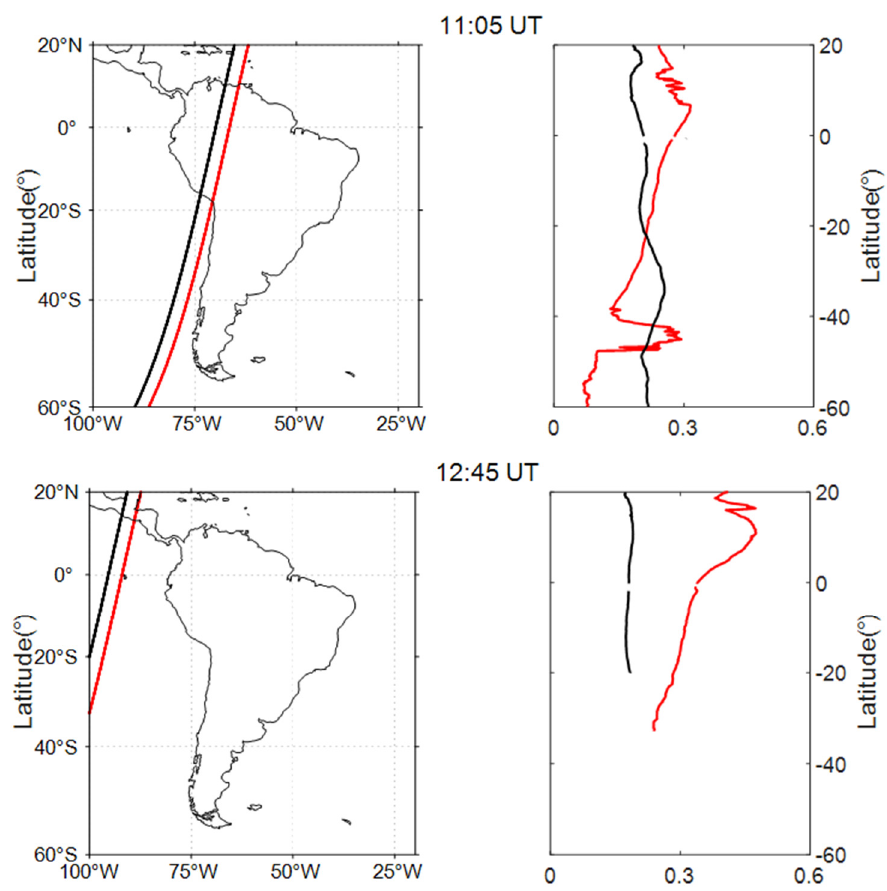
Figure 4. Satellite orbit of DMSP F-17 ( left column) and in situ electron density comparison ( right column) between the storm day (4 November) and the quiet day (3 November) close to 11:05 UT and 12:45 UT. The satellite orbit and electron density values on the storm day and the quiet day are represented by red lines and black lines, respectively.